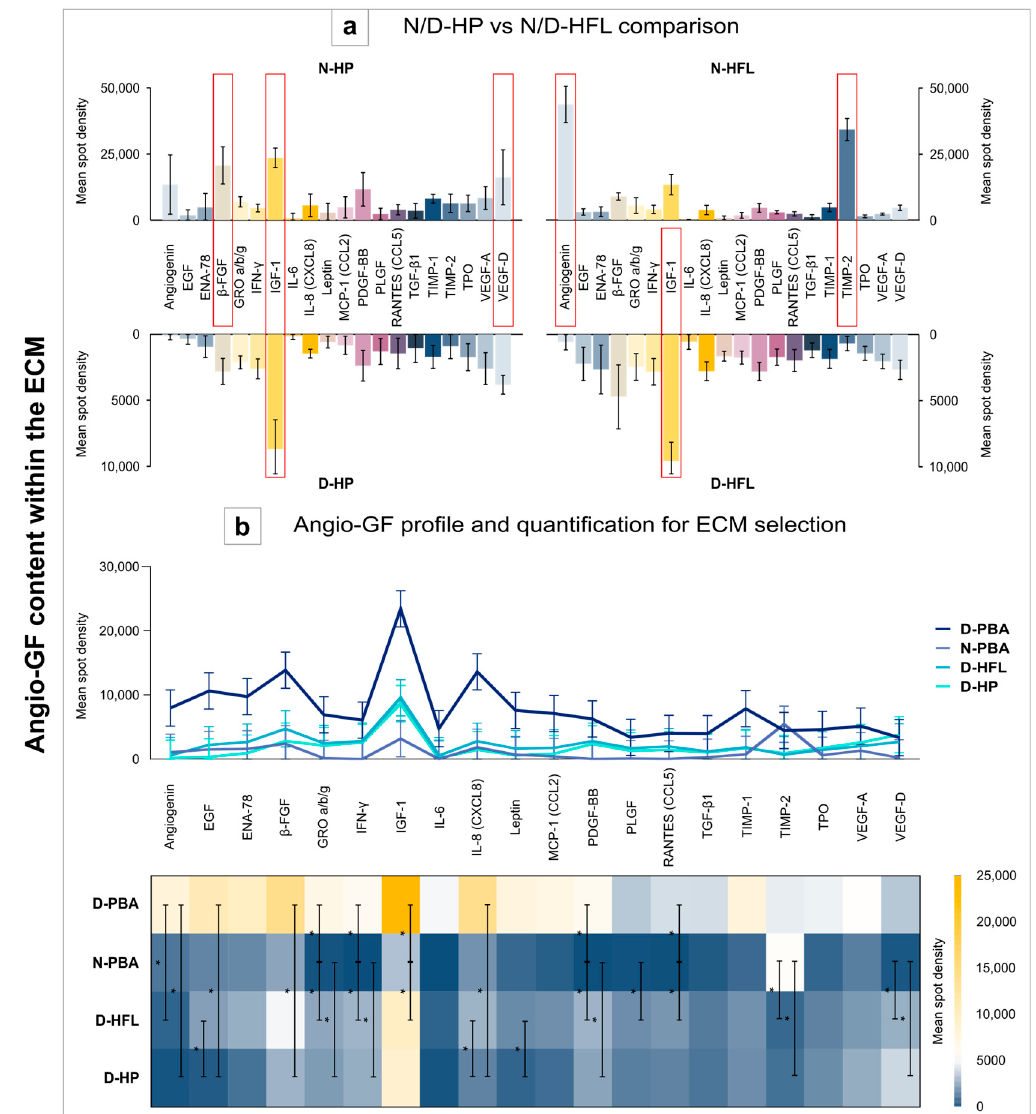
Figure 4. Evaluation of angio-induction potentials of ECMs via the angiogenic GF content in each matrix. The RayBio® C-Series Human Angiogenesis Antibody (Tebu-Bio, 126AAH-ANG-1-8, Le Perray-en-Yvelines, France) was used for this quantification (a and b). First, the D-HFL membrane, which is our membrane of interest, was compared with the periosteum ( a ). Then, the angiogenic GF content was expressed according to each ECM with a profile graph and a heatmap ( b ). Angio-GF: angiogenic growth factor, N/D-HP: native or decellularized human periosteum, N/D-HFL: native or decellularized human fascia lata, D-PBA: decellularized porcine bone allograft, and N-PBA: native porcine bone allograft. Error bars: 95% confidence interval (CI); *: p <